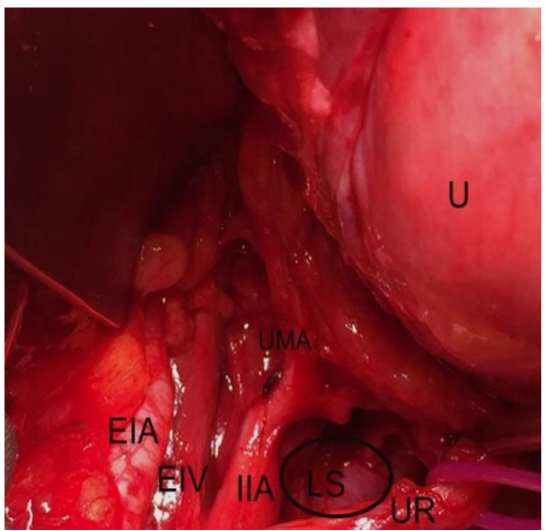
Figure 8. Latzko’s space dissected by open surgery (left side of the pelvis). U—uterus; UMA— umbilical artery; IIA—internal iliac artery; EIV—external iliac artery; EIV—external iliac vein, UR— ureter; LS—Latzko’s